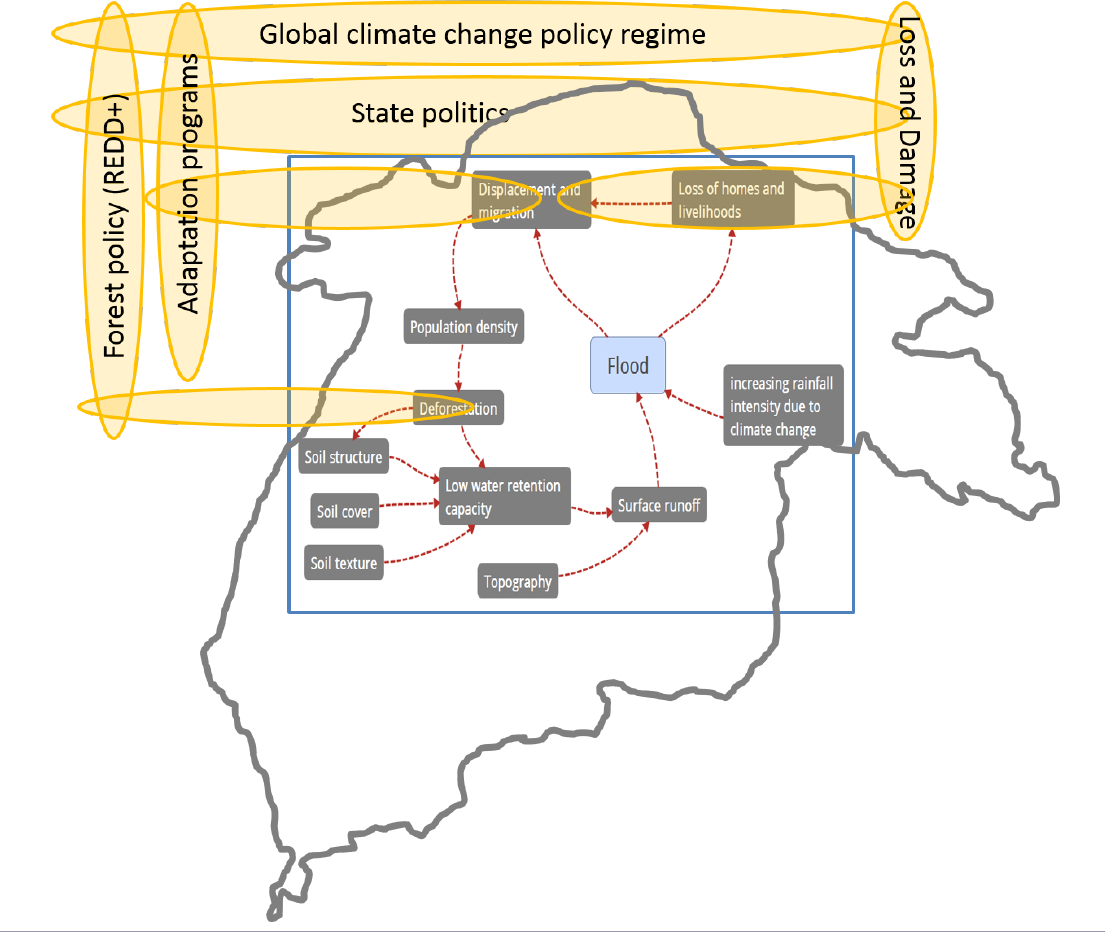
Fig. 1 . A stylized picture of how social fields (orange ovals) interact with geographically bounded components of a hydrological system (boxes and arrows) within the boundaries of the Indus river basin (thick black